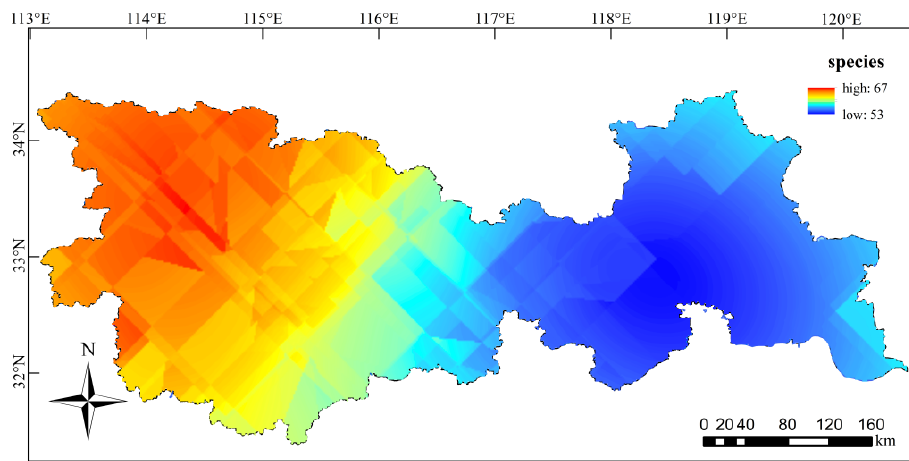
Figure 3. Variation in phytoplankton species in the Huaihe River Basin.